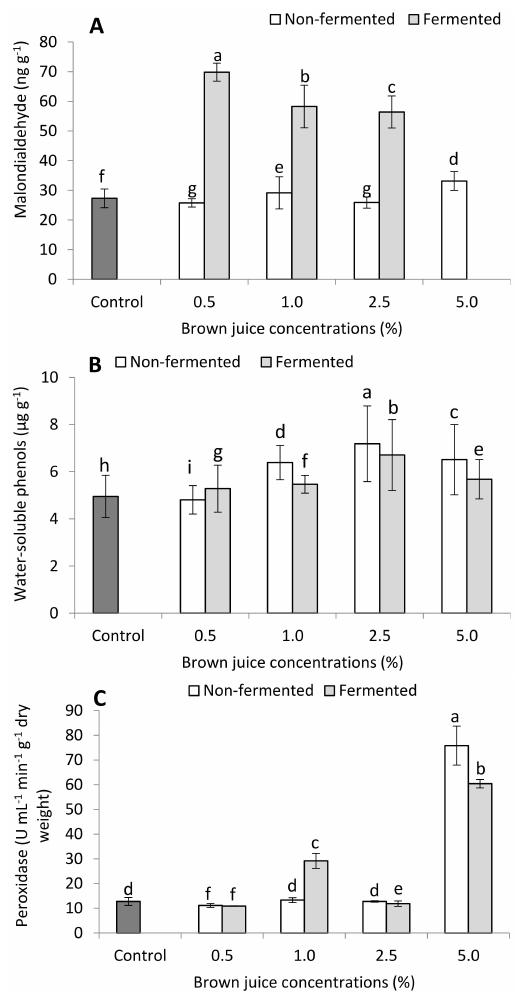
Figure 4. Effect of non-fermented and fermented BJ on the ( A ) malondialdehyde content, ( B ) water- soluble phenol content, and ( C ) peroxidase activity of French marigold plants ( n = 10). Different letters on the top of the bars indicate significant differences ( p ≤ 0.05). Data are presented as mean ± standard deviation. Data are absent for 5% (Figure 4A) fermented BJ treatment due to the inhibitory effect of high BJ concentration; plants